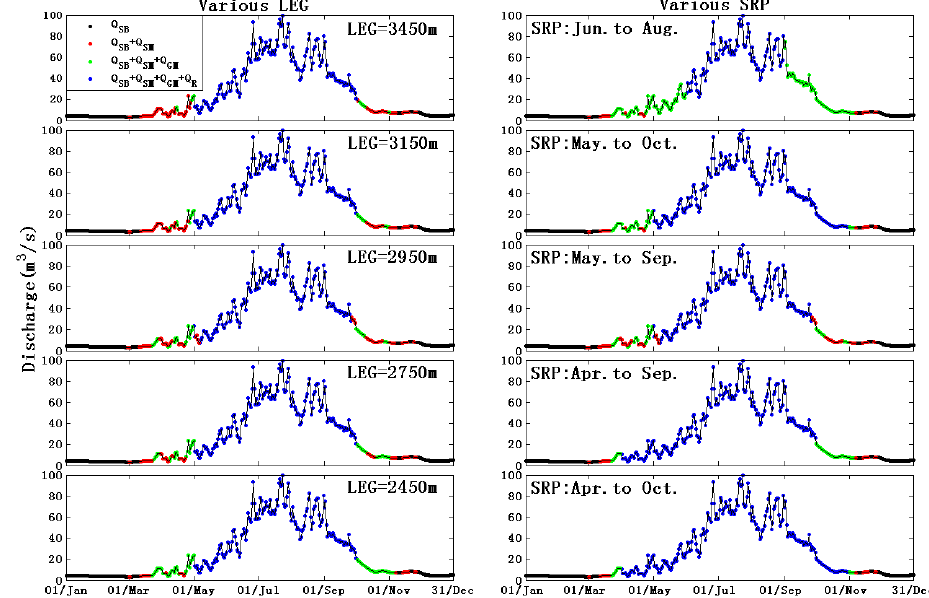
Figure 10. Sensitivity analysis for the hydrograph partition. The first column is the hydrograph partition pattern using different lowest elevation bands of the glacier area (LEGs). The second column is the hydrograph partition pattern using different storm rain periods (SRPs). Table 6. Sensitive analysis of the calibrated parameters on lowest elevation band for glacier area (LEG) and storm rain period (SRP). NSE is the Nash–Sutcliffe efficiency value for the calibration